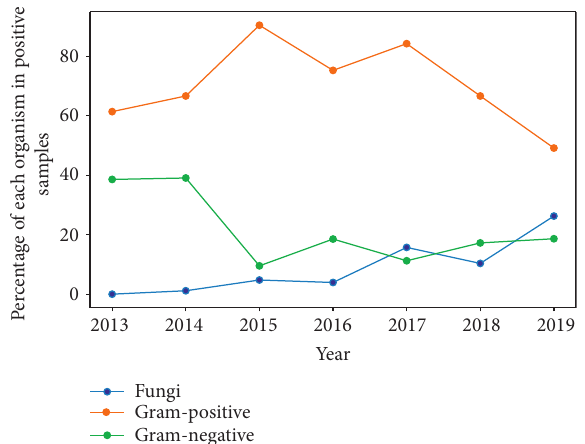
Figure 9: Percentage of each organism in positive